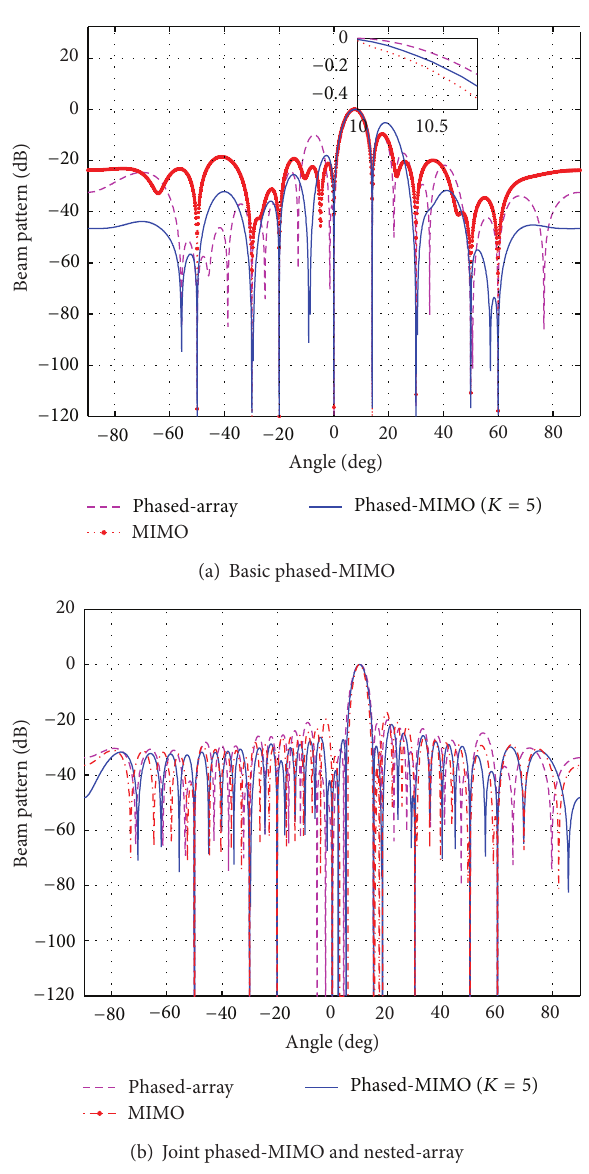
Figure 4: Comparative MVDR beam pattern when 𝐷 = 8